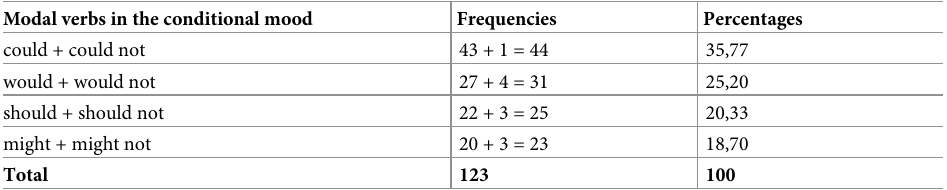
Table 6. Frequencies and percentages of modal verbs in the conditional mood. Modal verbs in the conditional